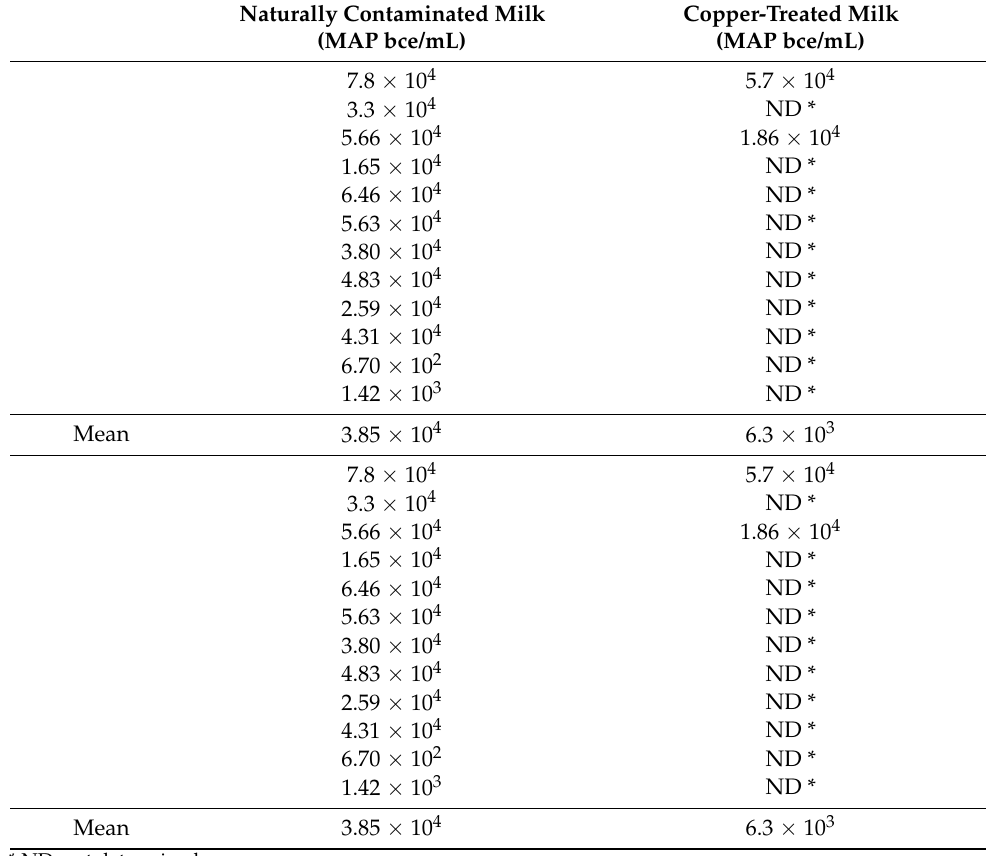
Table 1. Estimated MAP concentration in naturally contaminated milk samples determined by qPCR before and after treatment with copper ions. Data represent number of MAP bacterial cell equivalents per mL of milk (centrifuged at 2500 × g and resuspended in 1 mL of PBS). Calf milk replacer and UHT milk were also tested but no MAP bacteria were detected.